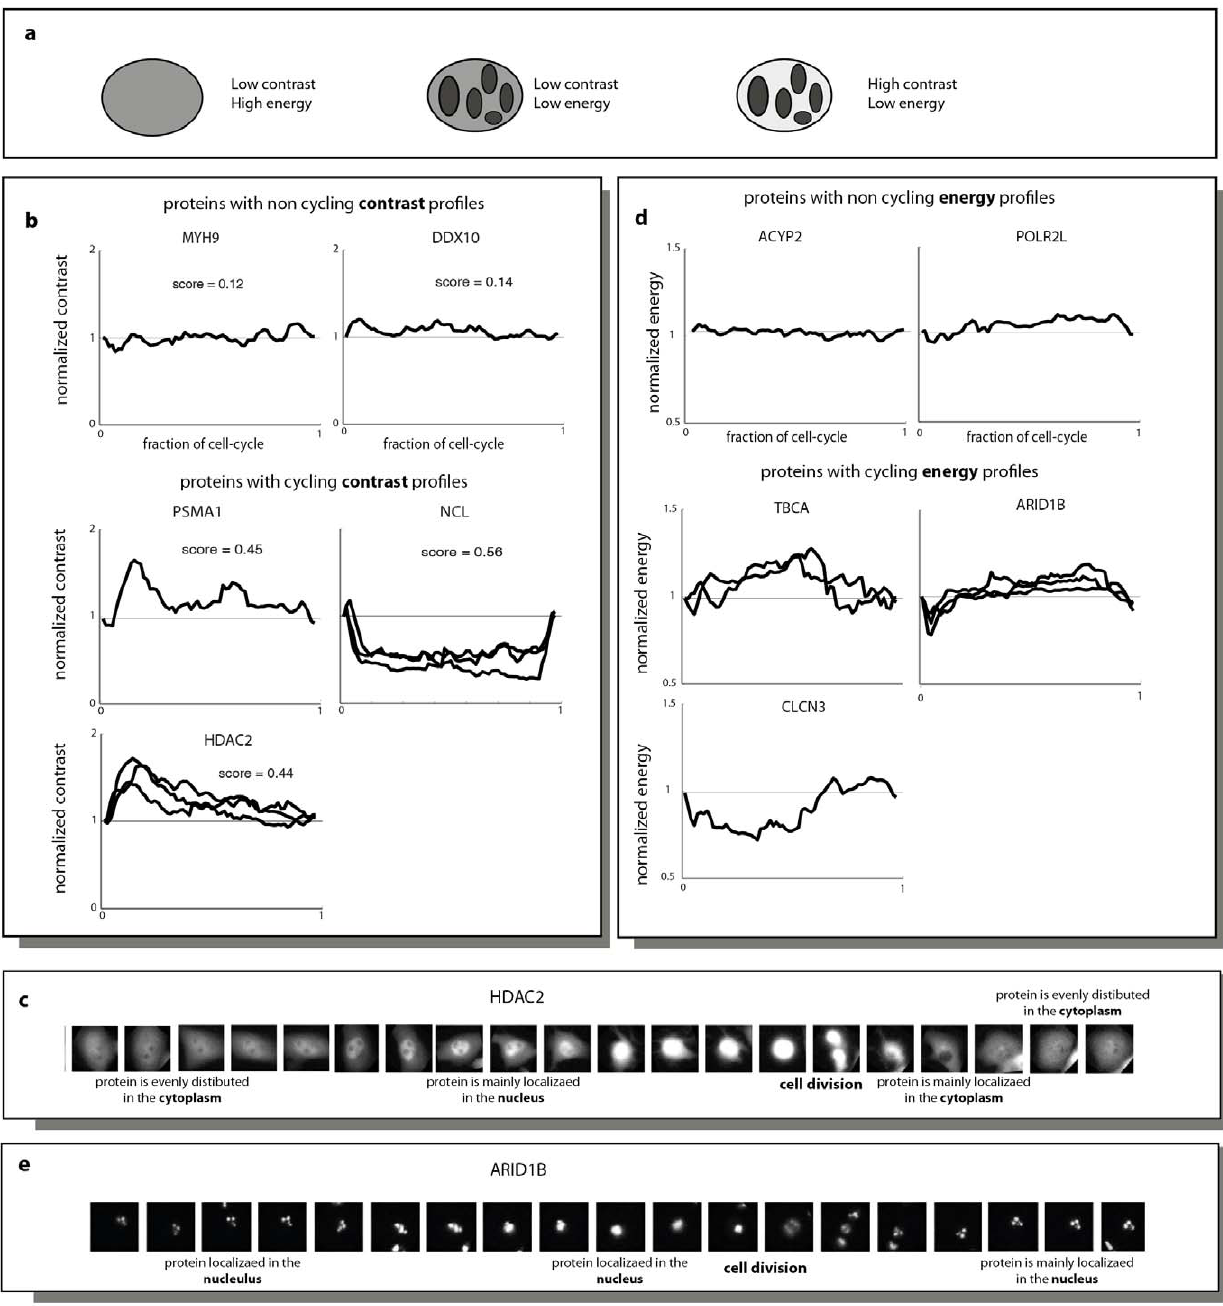
Figure 4. Cell cycle dependence of protein localization using texture features. (A) Illustrations of different cells texture. Note that while the energy ), doesn’t take into account the absolute differences in intensity, those are taken into account in the contrast calculation (, and so, similar cells can have same energy, but different contrast (the 2 cells on the left). (B) Normalized profiles of the contrast along the cell cycle are shown for a few proteins. (C) A series of images from a single cell from a clone that expresses HDAC2 fused to YFP. (D) Normalized profiles of the energy along the cell cycle are shown for a few proteins. (E) A series of images from a single cell from a clone that expresses ARID1B fused to YFP.